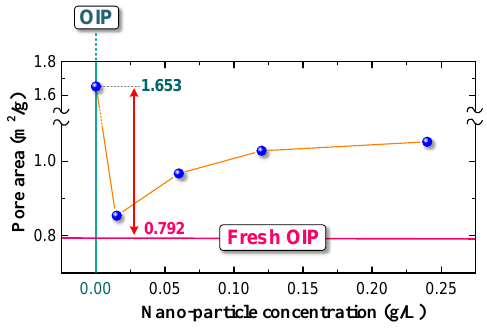
Figure 20. Pore area in fresh OIP and OIP/NOIP subjected to 500 impulse voltage.